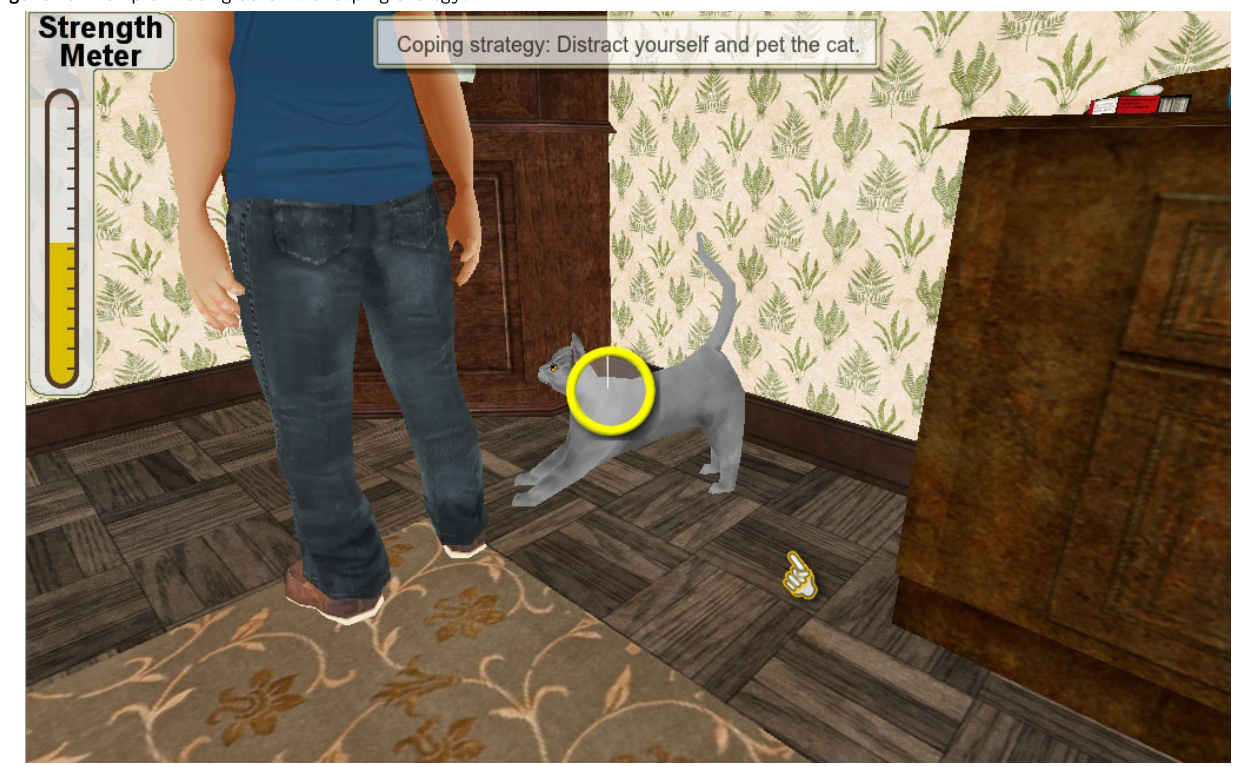
Figure 4. Example of using behavioral coping